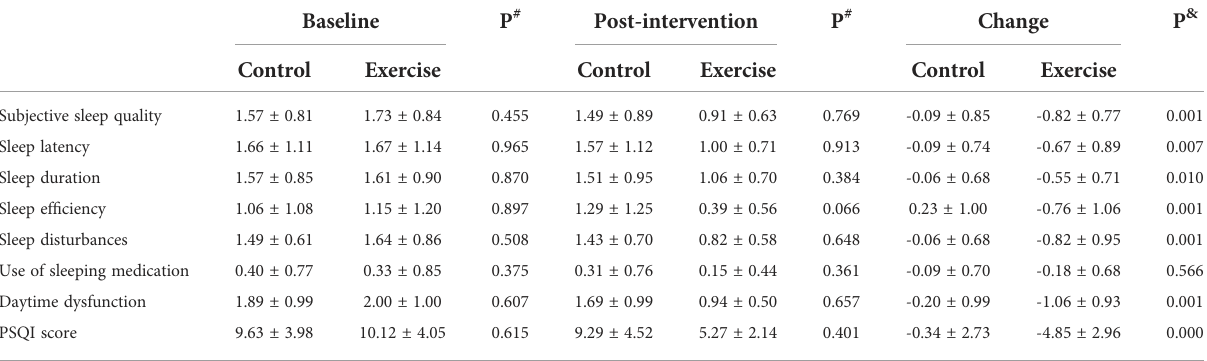
TABLE 3 Effects of Baduanjin on sleep quality index (PSQI)*.